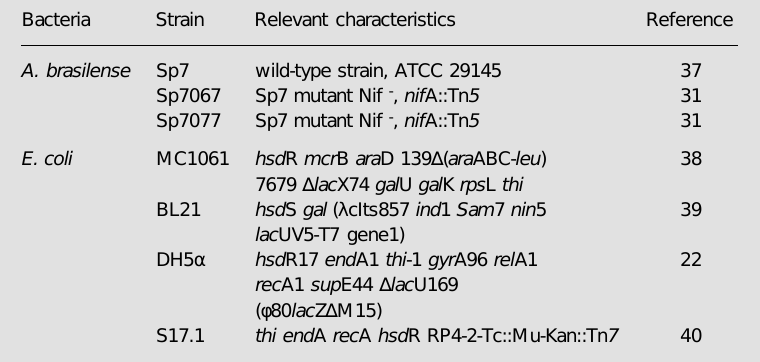
Table 1 - Bacterial strains used in the present study.